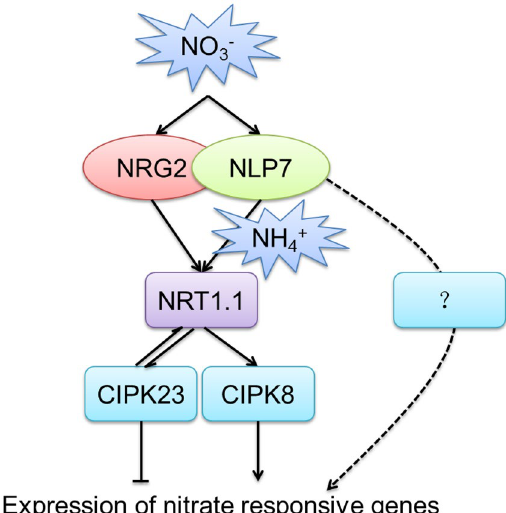
Figure 6. Proposed model for the nitrate regulatory genes in the nitrate signaling. NLP7 regulates nitrate signaling upstream of NRT1.1 when NH 4 + is present and may regulate an NRT1.1 -independent pathway in the absence of NH 4 + in nitrate signaling. NLP7 interacts with NRG2 and NRG2 works upstream of NRT1.1 when NH 4 + is present and/or absent. NRT1.1 regulates CIPK8 and CIPK23 at the transcript level. CIPK23